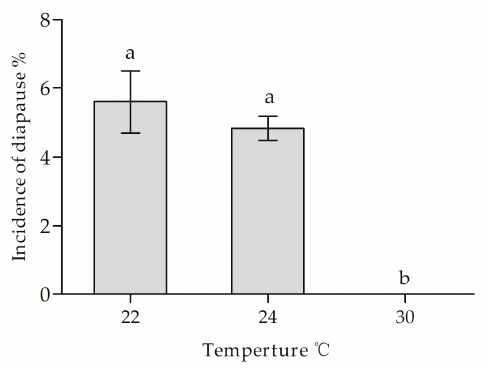
Figure 6. Incidence of diapause in Ln strain under different temperatures. Symbols and bars repre- sent the mean ± SE values. Different lowercase letters indicate significant differences ( p < 0.05) among diapause incidence in the Ln strain.